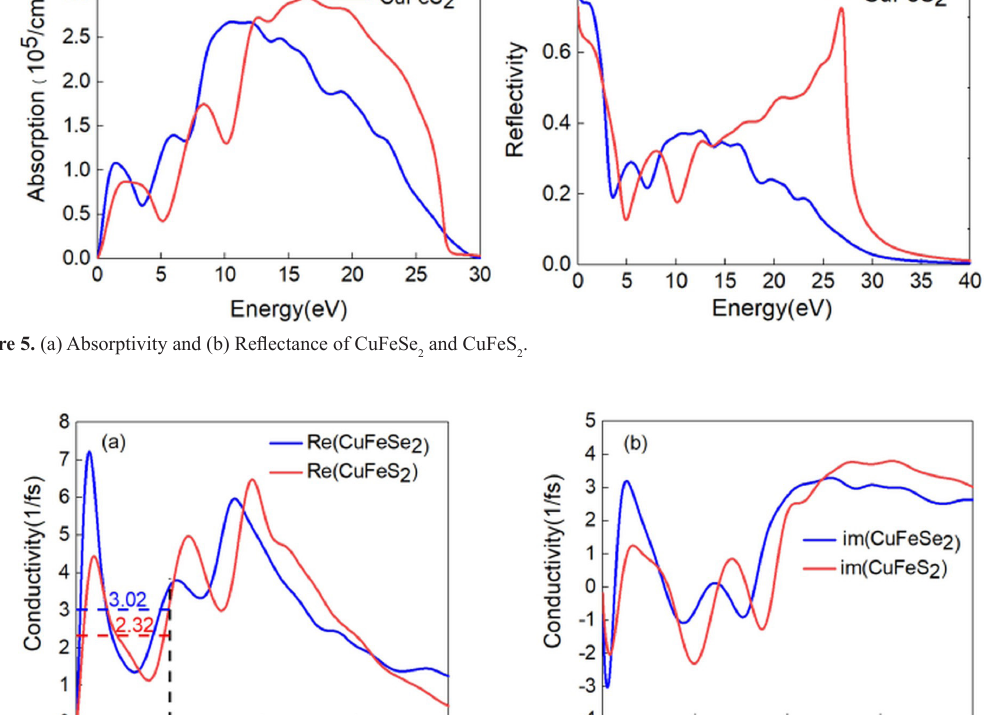
Figure 6. (a) real part and (b) imaginary part of photoconductivity of CuFeSe